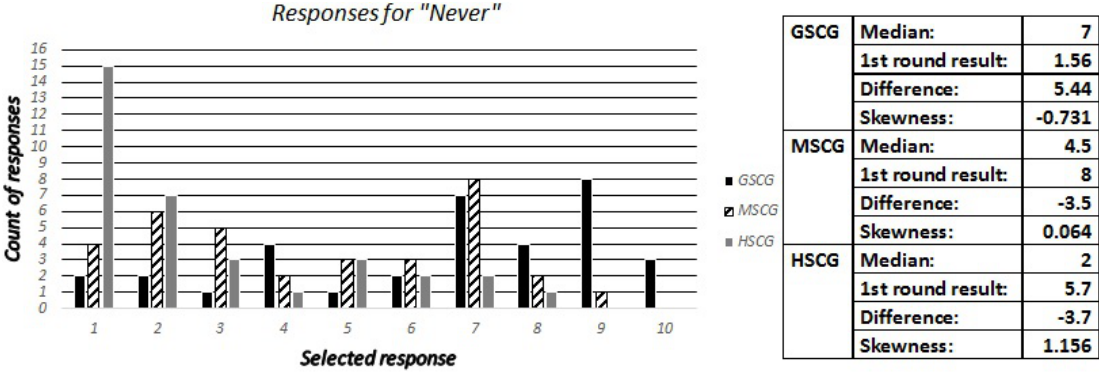
Figure 6. Expert predictions for question 4, Distribution of “Never”-response and comparison